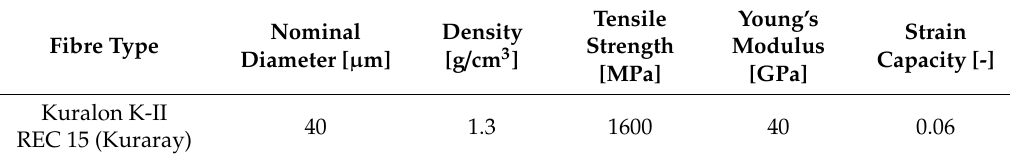
Table 2. Physical and mechanical properties of the polyvinyl alcohol (PVA)